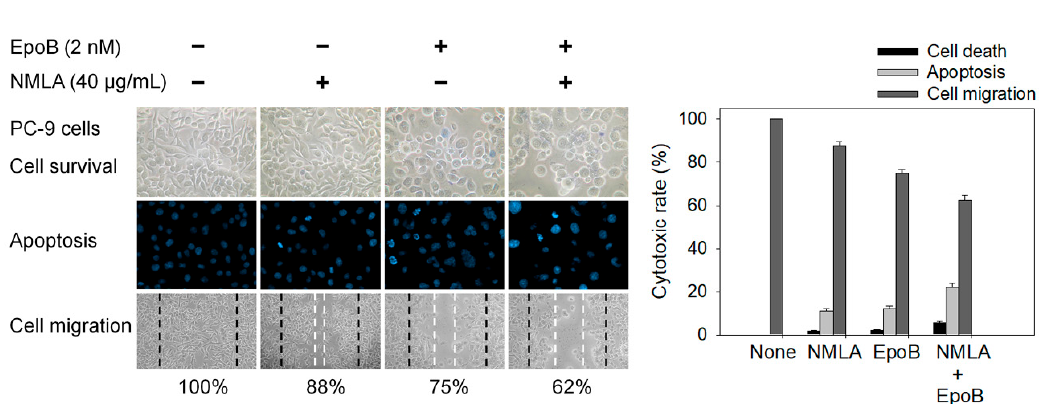
Figure 5. The co-cytotoxic effects of epothilone B with N. miranda -leaf-acetone. N. miranda -leaf-acetone (NMLA; 40 μ g/mL) and epothilone B (EpoB; 2 nM) were used to investigate the cytotoxic effects on cell survival, migration, and apoptosis. The collective data suggested no potential synergistic cytotoxic effects.